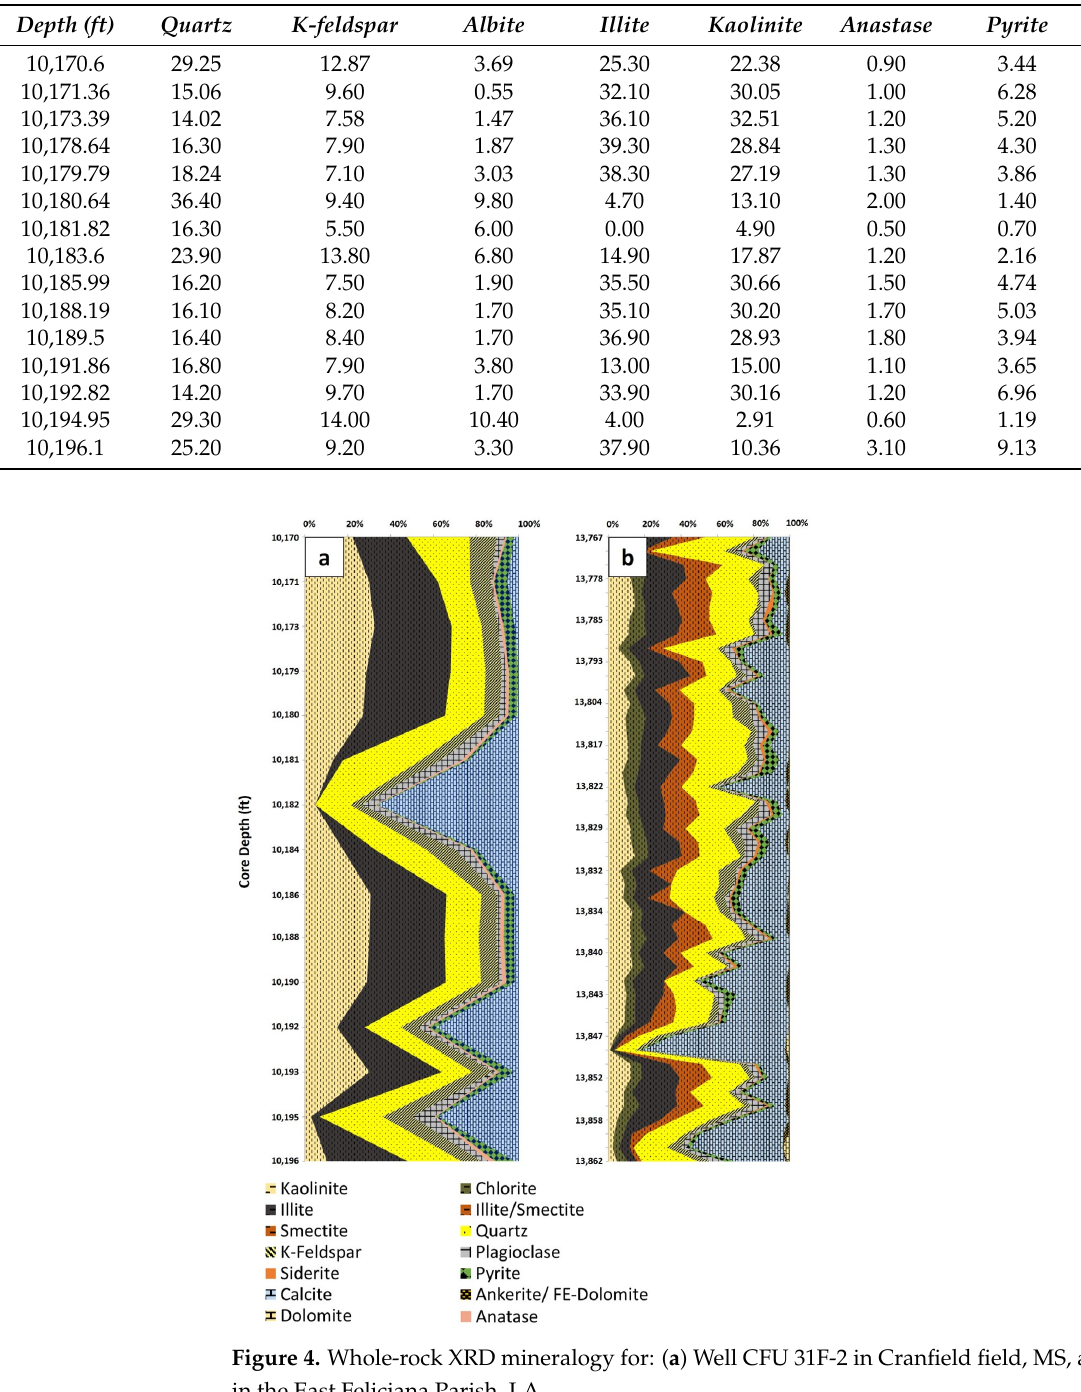
Table 1. Whole-rock XRD mineralogy results for Well CFU 31F-2 in Cranfield field, MS. Adapted from Lu et al. (2011) [6].